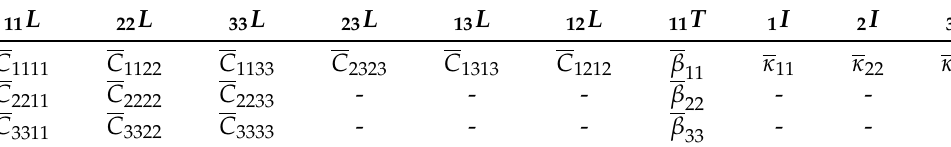
Table 1. Relationship between the local problems and the effective